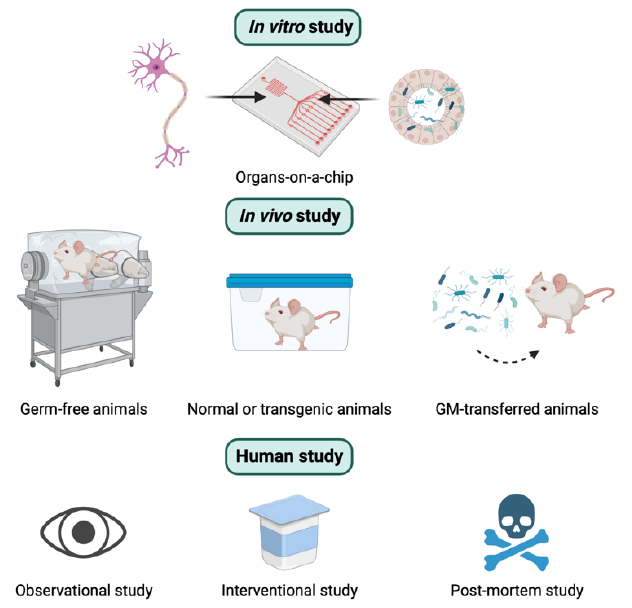
Figure 2. Three different types of experimental approaches to studying the role of the microbiota-gut-brain axis in the pathogenesis of Alzheimer’s disease. See the text below for the details.